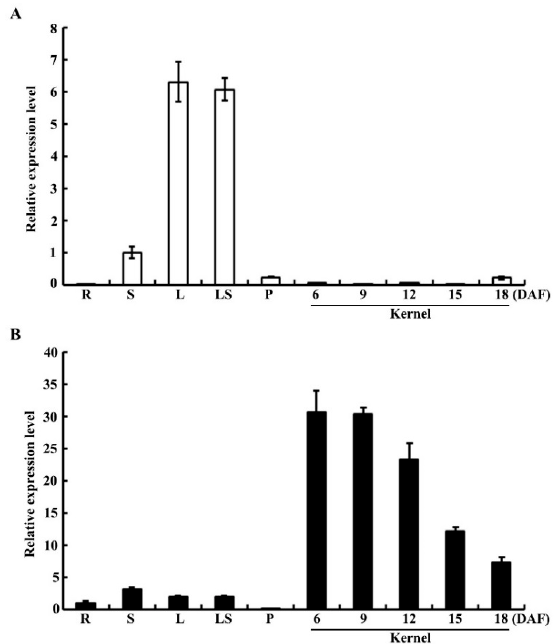
Figure 5. Expression pattern of OsPPDKB . ( A ) Expression analysis of the chOsPPDKB in various tissues and developing kernels of WT. ( B ) Expression analysis of the cyOsPPDKB in various tissues and developing kernels of WT. R, root; S, stem; L, leaf; LS, leaf sheath; P, panicle. Actin1 is used as an internal control. All data are given as means ± SD ( n = 3).